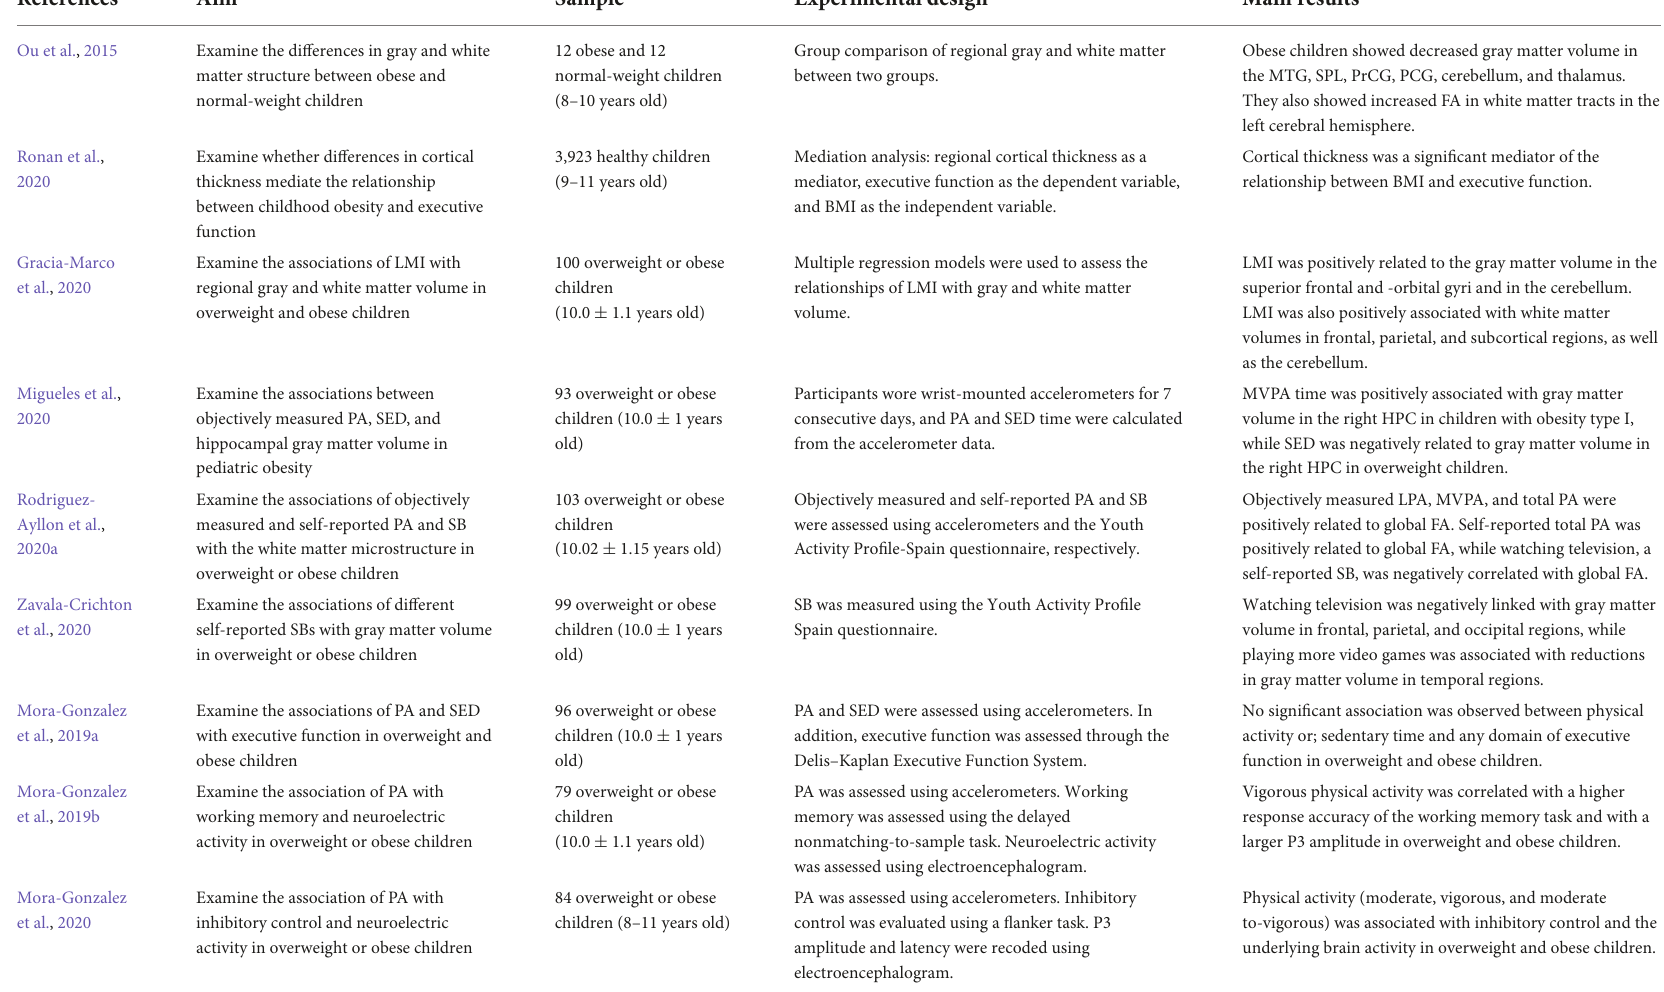
TABLE 1 Summary and key findings of the neuroimaging studies in this literature